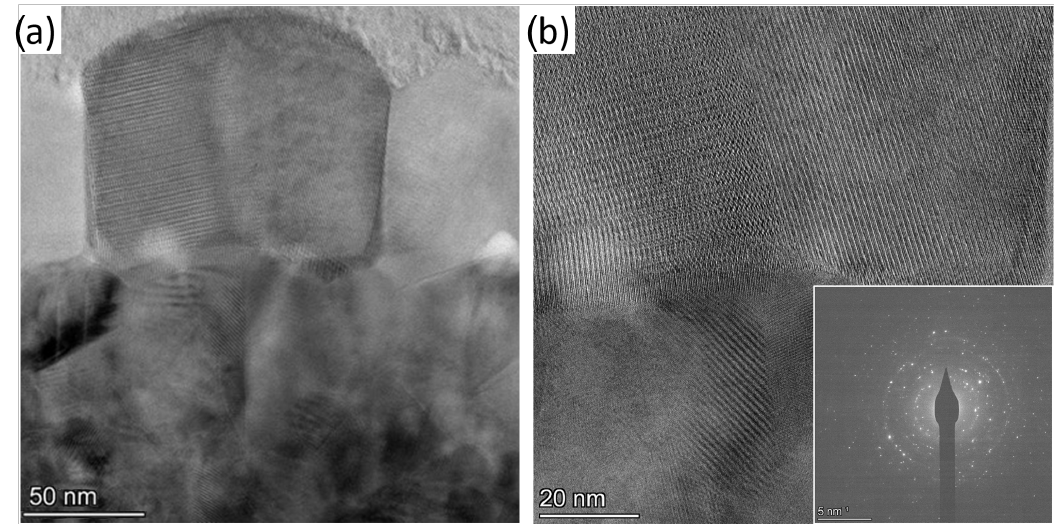
Figure 3. ( a ) TEM images of the VO x film, showing around 100nm large crytalline particle in the middle. ( b ) High resolution TEM image exhibiting crystalline atomic structure. The inset shows the diffraction pattern of a grain in the VO x